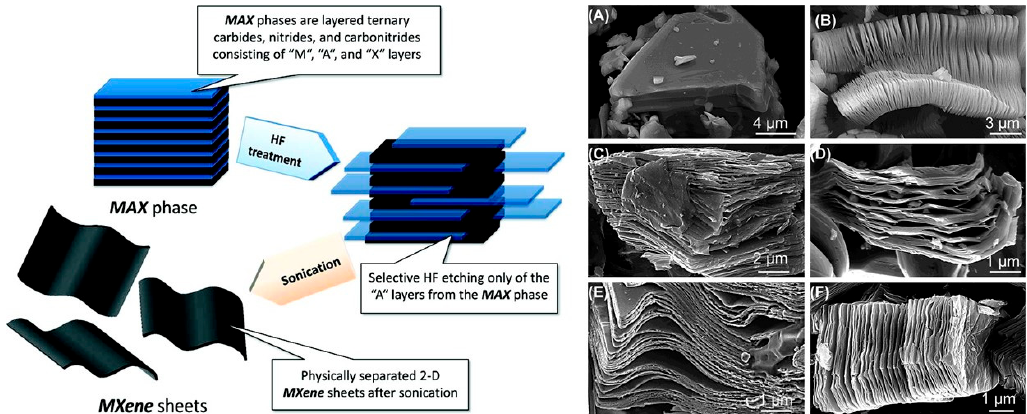
Figure 1. (Left) Schematic for the exfoliation process of MAX phases and formation of MXenes. (right) SEM micrographs for ( A ) Ti 3 AlC 2 MAX phases, ( B ) Ti 3 AlC 2 after HF treatment, ( C ) Ti 2 AlC after HF treatment, ( D ) Ta 4 AlC 3 after HF treatment, ( E ) TiNbAlC after HF treatment, and ( F ) Ti 3 AlCN after HF treatment. Reprint with permission [2]. Copyright © 2012, American Chemical Society.